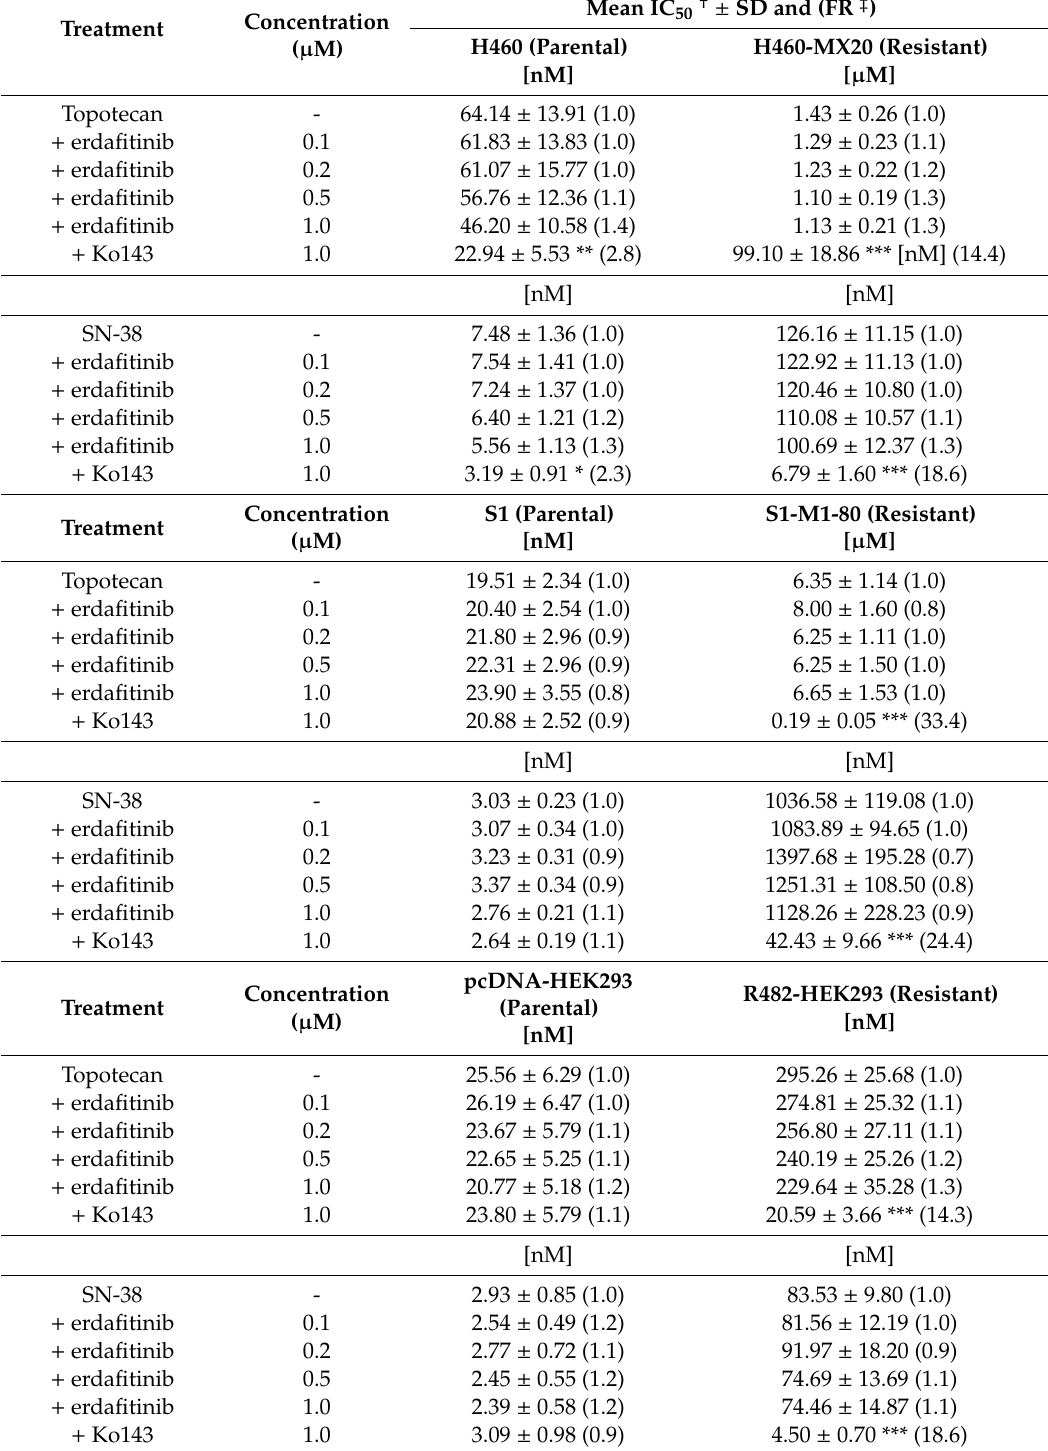
Table 3. The e ff ect of erdafitinib on ABCG2-mediated multidrug resistance in ABCG2-overexpressing human cell